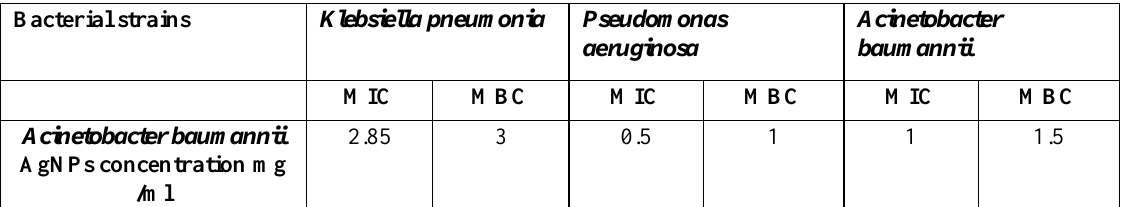
Table 4. MIC and MBC Acinetobacter baumannii AgNPs concentration by mg/ml on Klebsiella pneumonia